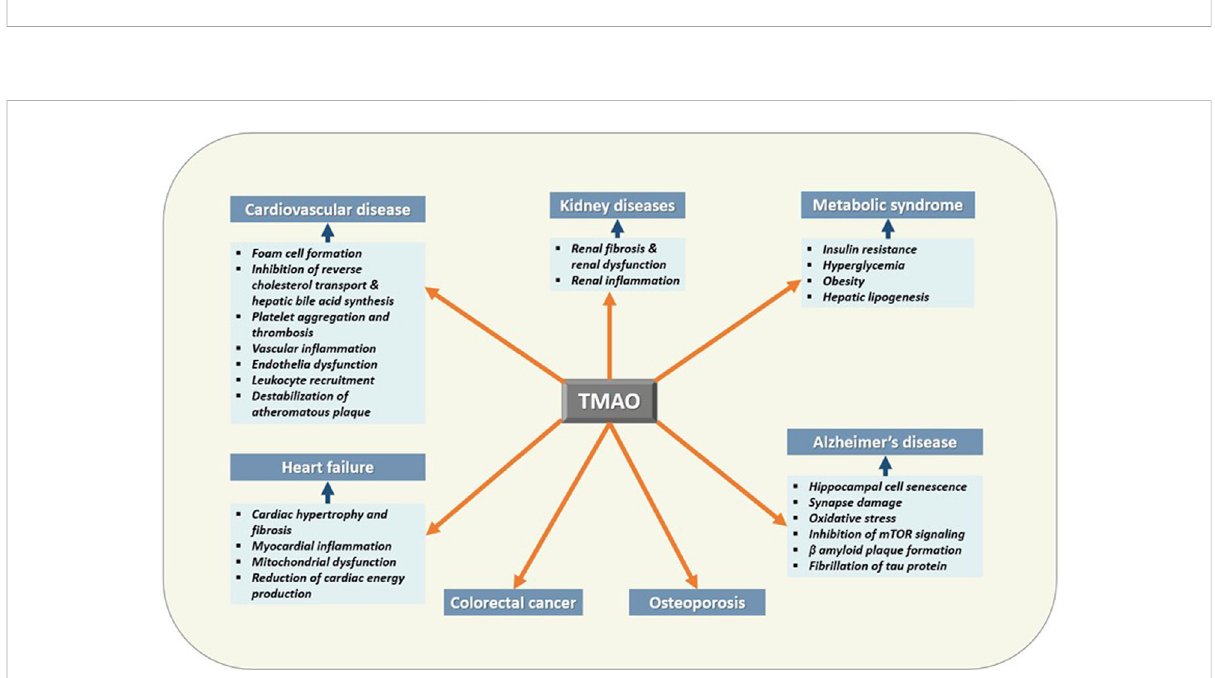
EffectsofTMAOonhumanhealthanddisease.TMAOisassociatedwiththepathogenesisofseveralhumandiseases.Therefore,elevatedserum TMAO can be considered a risk factor as well as can be used as a biomarker for these